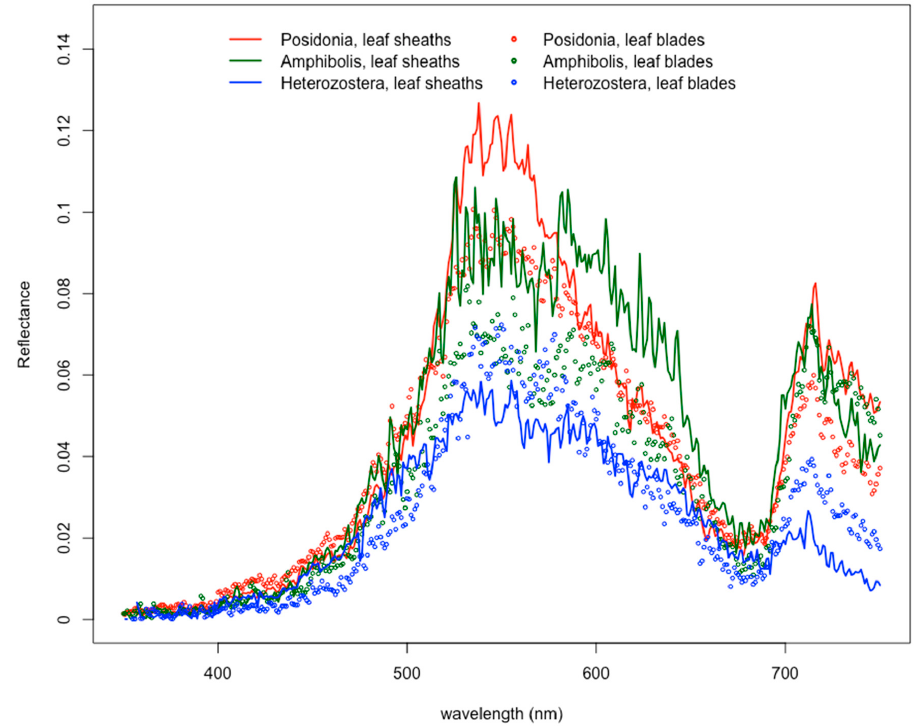
Figure 6. Differences in reflectance spectra based on location of epiphytes on seagrass leaf blades and leaf sheaths.